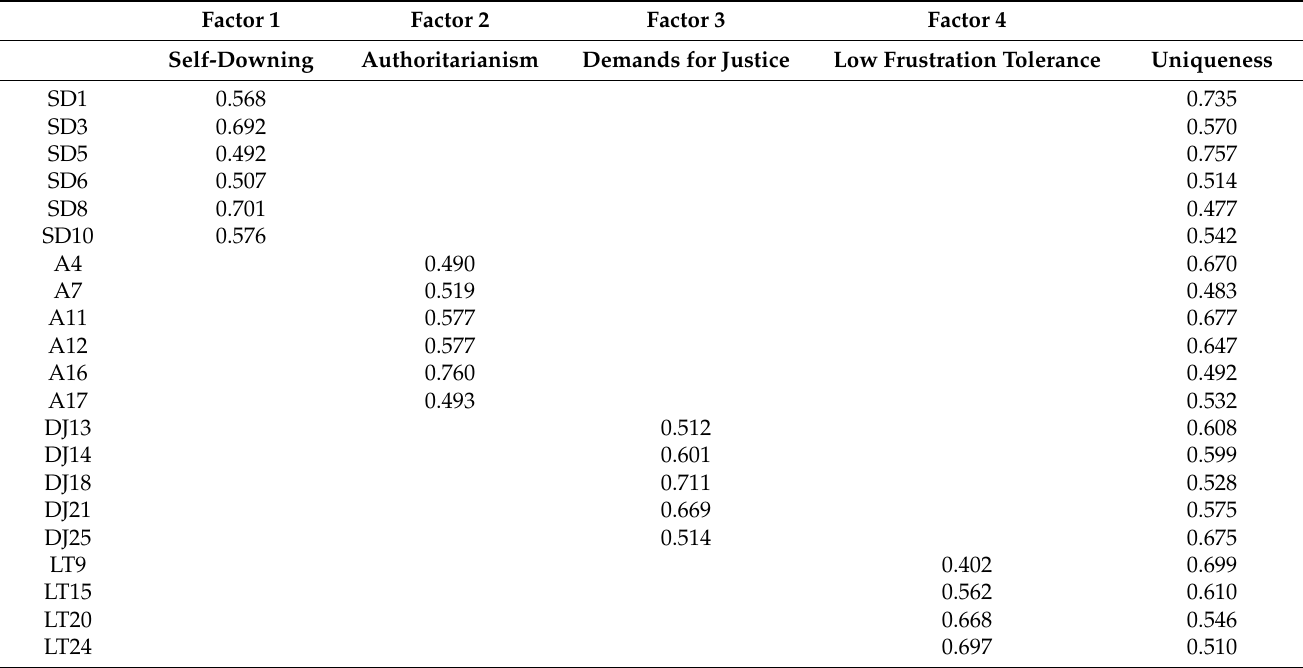
Table 1. Factor loadings of four-dimensional